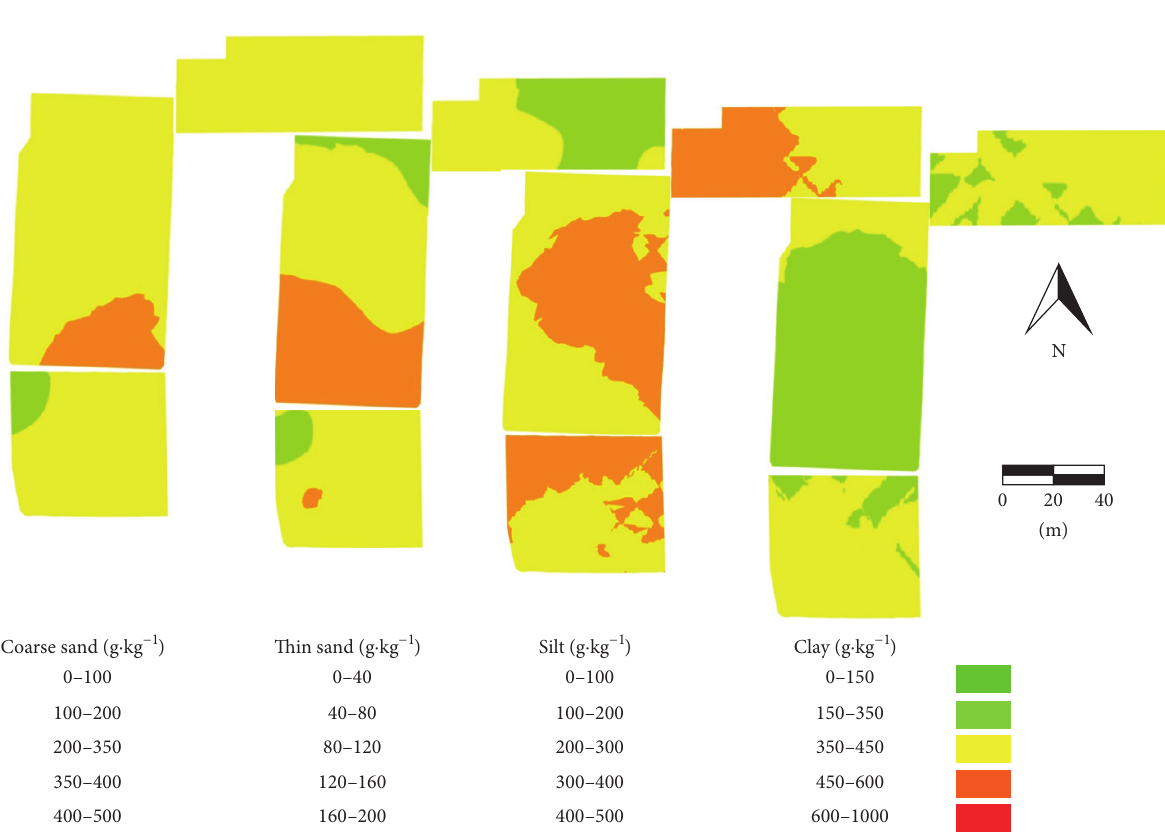
Figure 3: Spatial distribution of granulometric variables related to Ap horizon in the study area.